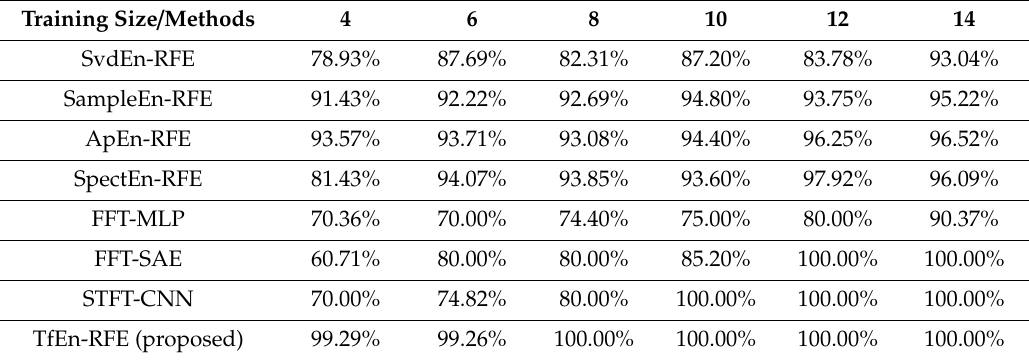
Table 5. Detailed classification accuracy of each method with various training